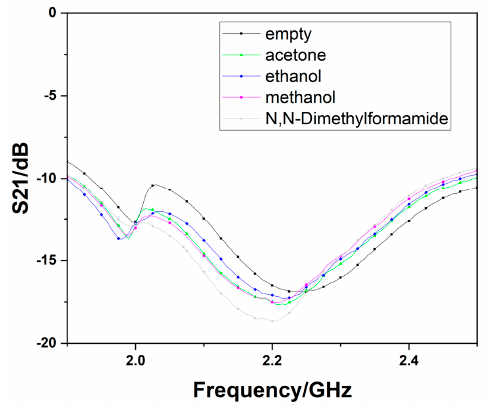
Figure 8. The measurement results of the bare devices.